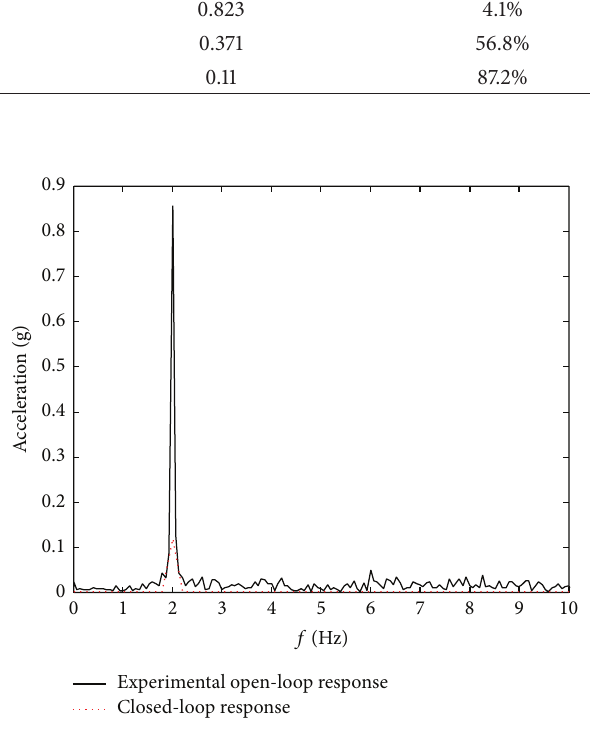
Figure 5: The comparison of open-loop and closed-loop accelera- tions in the frequency